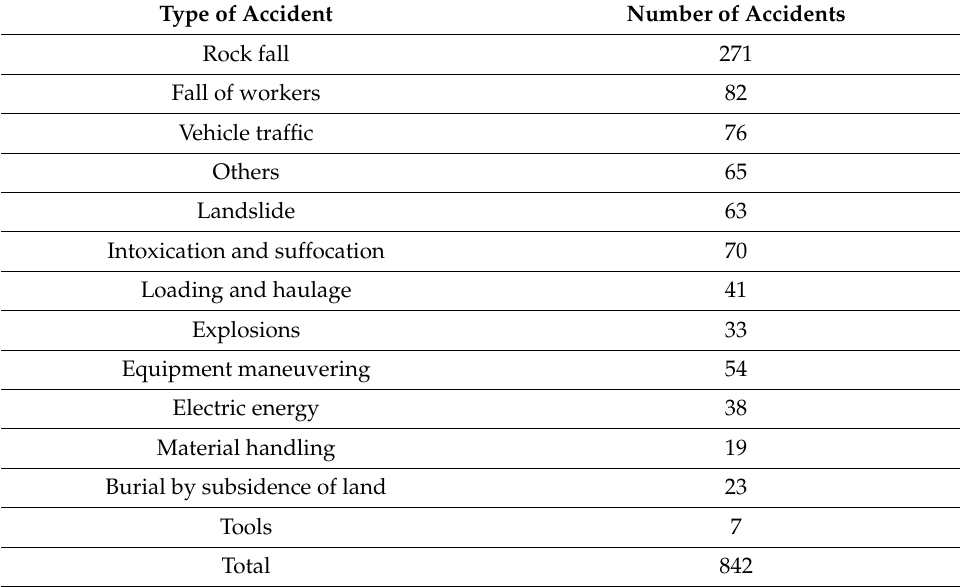
Table 1. Number of accidents resulting in death in Peru (2000–2016).